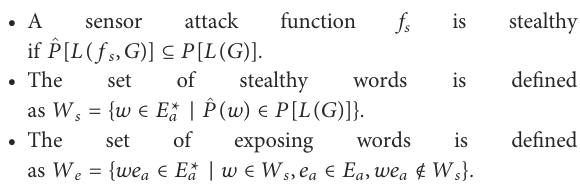
FIGURE 4 Fake diagnoser D f in Example